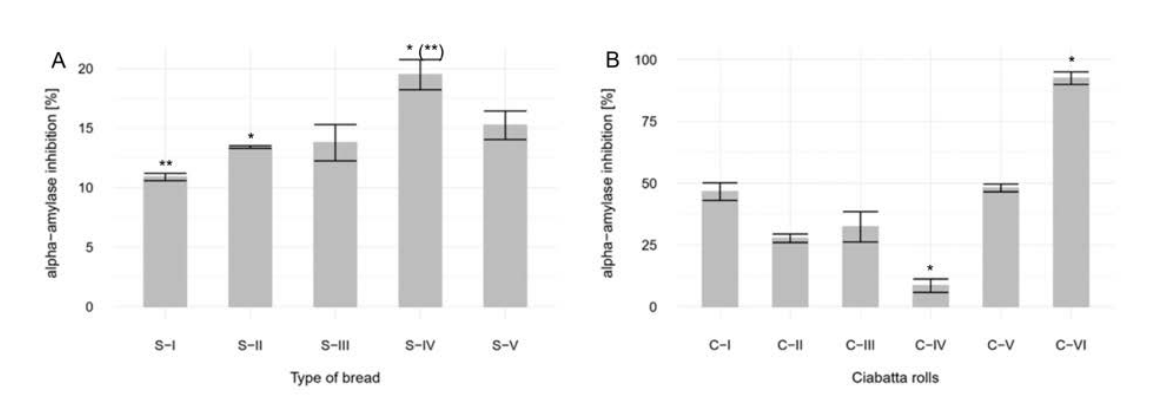
Figure 1. ( A ). Percentage of α -amylase inhibition in different types of sourdough bread compared to yeast bread, in which α -amylase inhibition is 0%. Samples marked with * and ** are statistical significance at the p < 0.05 level. ( B ). Percentage of α -amylase inhibition in ciabatta rolls compared to yeast bread, where α -amylase inhibition is 0%. Samples marked with * are statistical significance at the p < 0.05